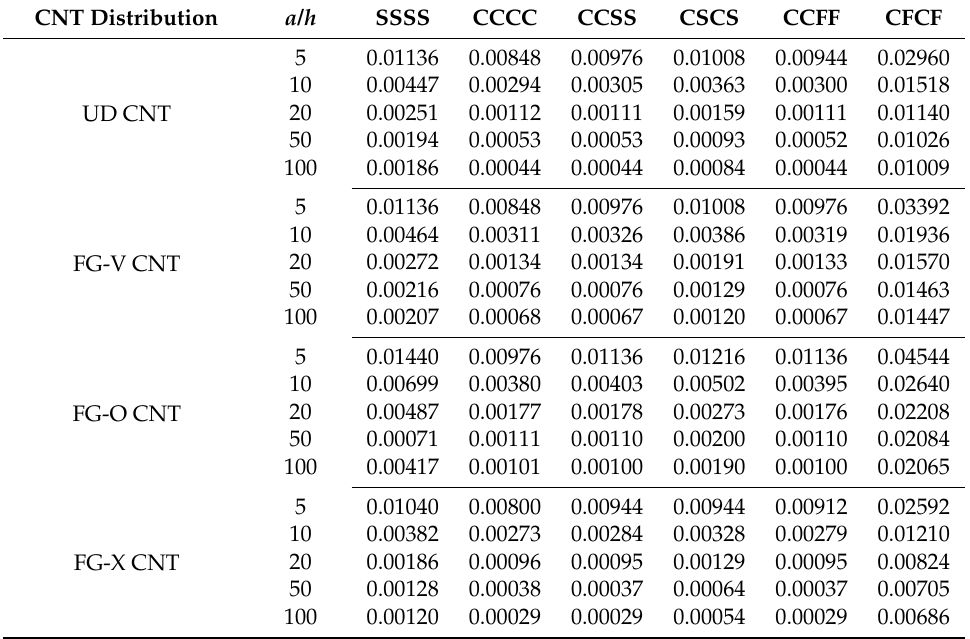
Table 12. Central transverse deflection of an FG-CNT-reinforced square plate subjected to sin-sin = loading V ∗ CNT